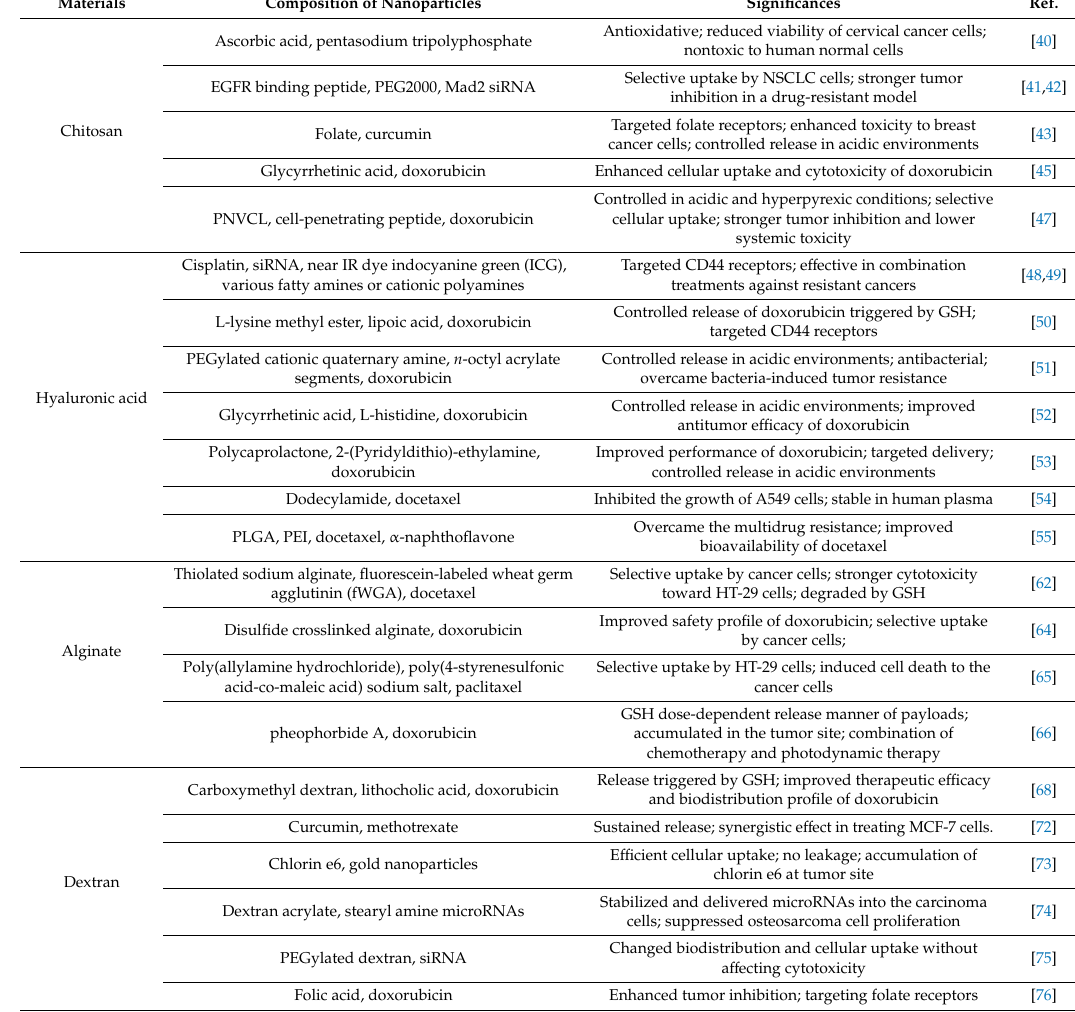
Table 1. Examples of polysaccharides-based